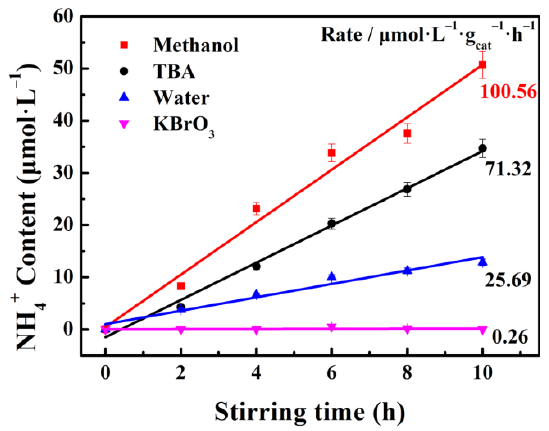
Figure 5. Tribocatalytic N 2 fixation performance of g-C 3 N 4 with the different scavengers.